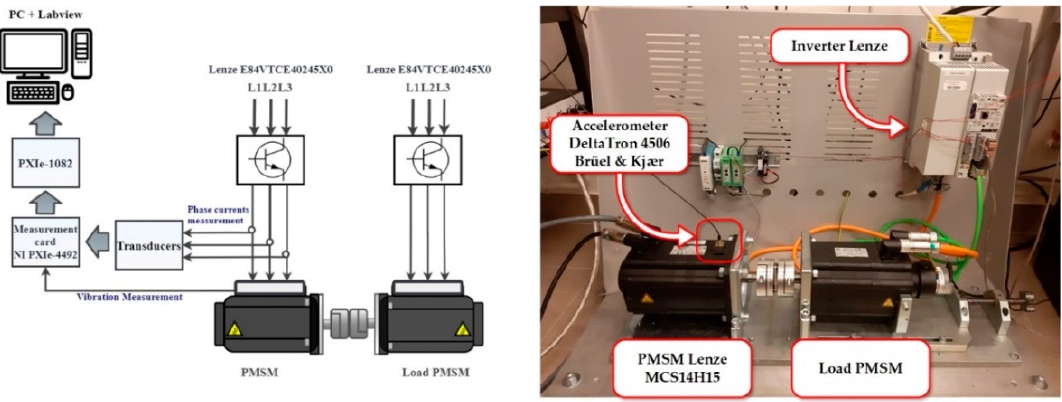
Figure 5. Schematic diagram and photo of the laboratory